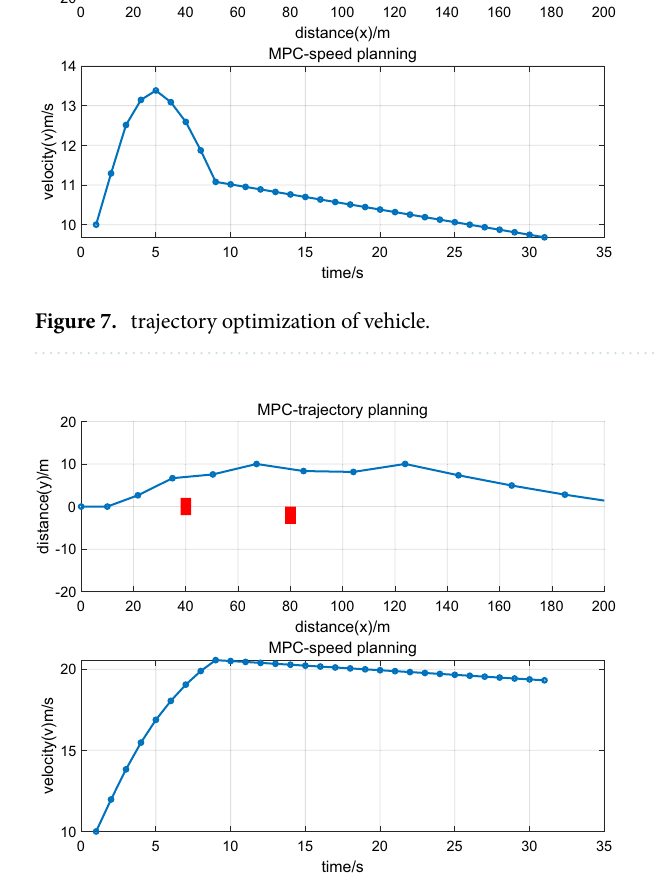
Figure 8. trajectory optimization of